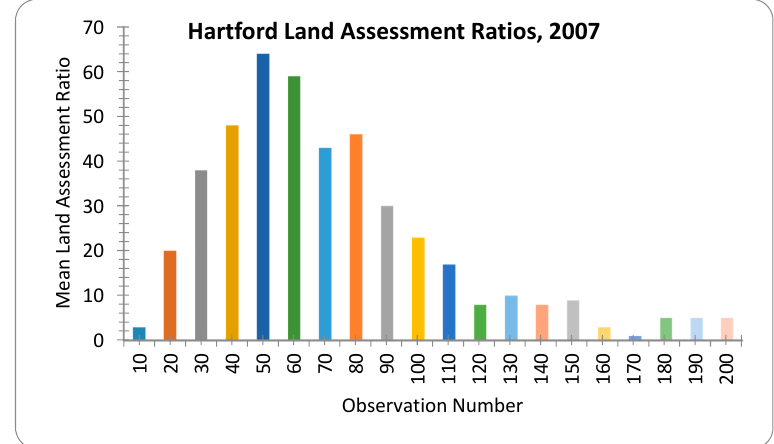
Figure 9. Hartford Land assessment ratios for the tax year 2007. The observation number (horizontal axis) is a range, and the Mean Land Assessment Ratio (vertical axis) is the mean overall ratio in the corresponding range. For instance, 10 indicates observations 0 to 10; 20 indicates observations 11 to 20; …; 200 indicates observations 200 and over.